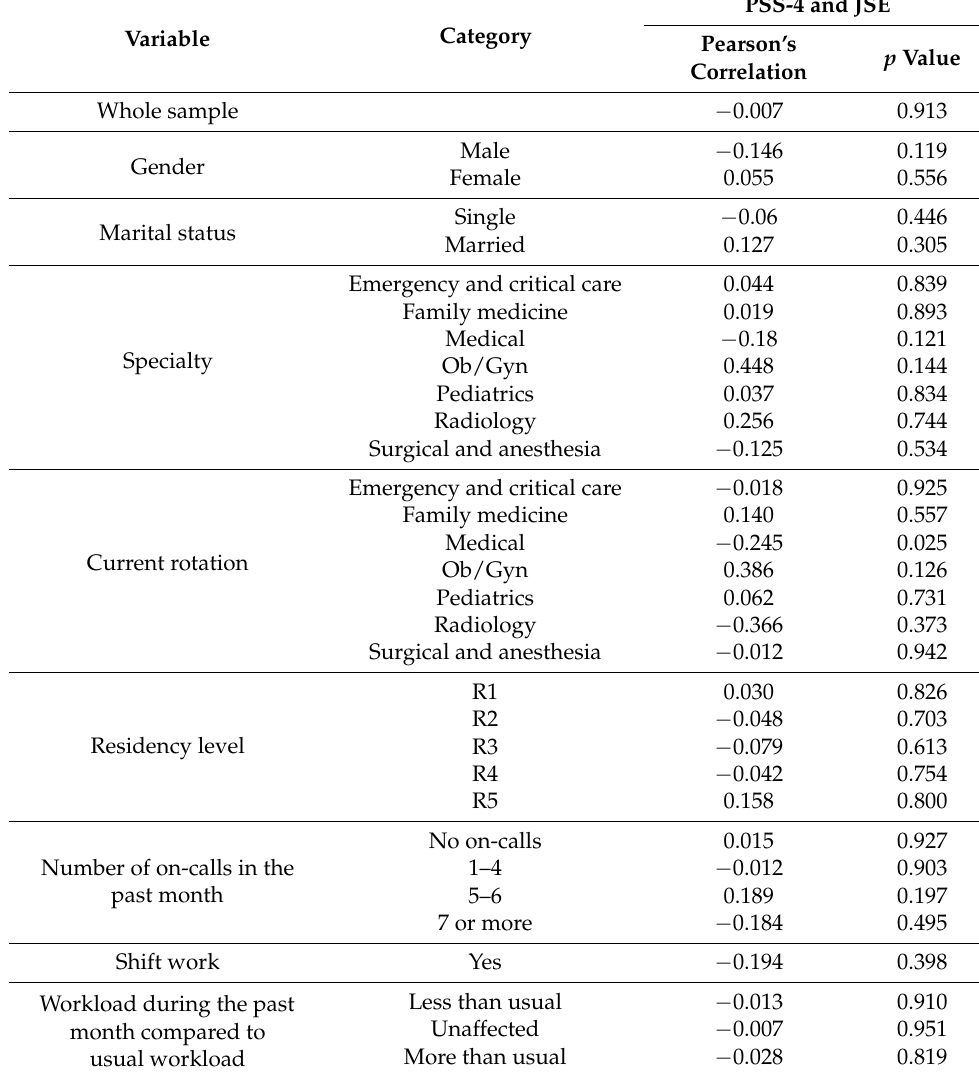
Table 4. Correlations between PSS-4 and JSE scores for the whole sample and across sociodemo- graphic and training characteristics ( n =